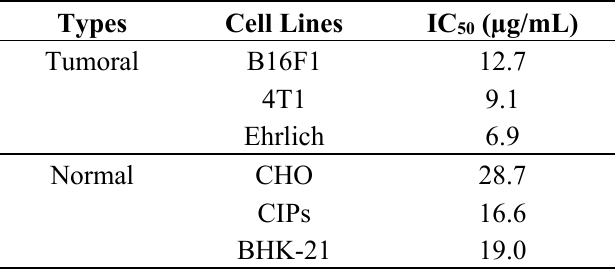
Table 1. Cytotoxicity of P1G10 fraction (IC 50 ) in normal and tumor cell lines . Types